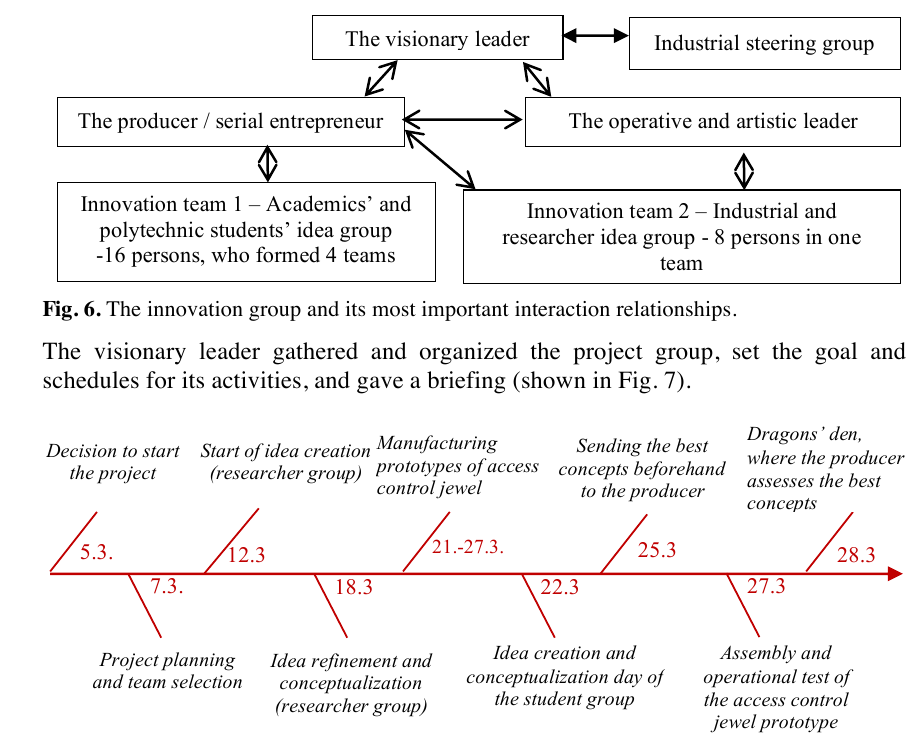
Fig. 7 . Schedule and main events of the FEI